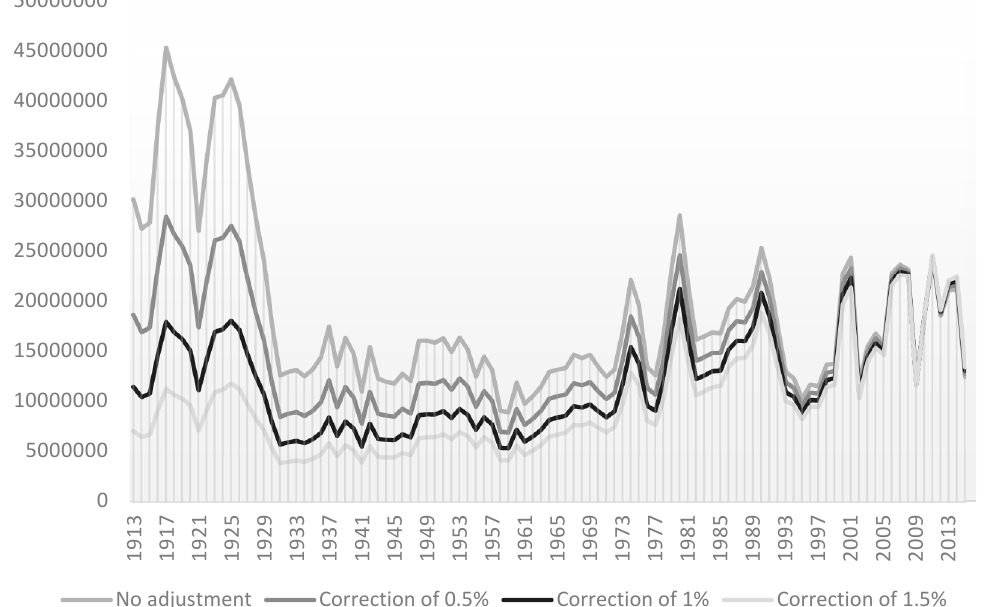
Figure 1. Annual real prices of Platinum Group Metals (PGMs) in dollars per metric ton ($/ton) from 1913 to 2015 (2010 = 100%).